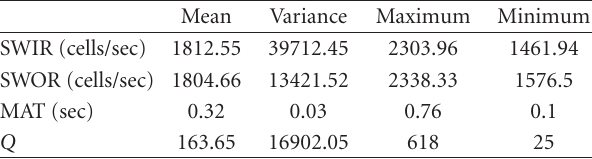
Table 4: The values of the SWIR, SWOR, MAT, and Q .